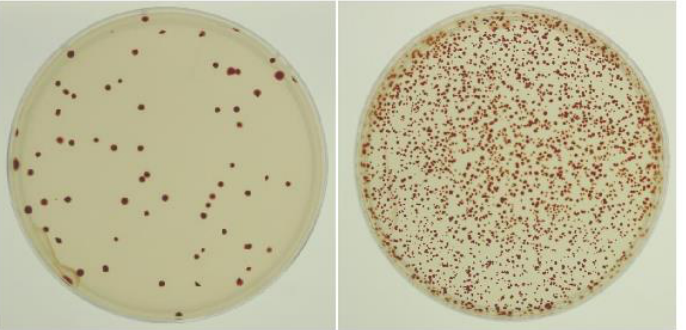
Figure 1. Representative plates from a transduction assay. ( Left ) mixed culture of strains DW5 and ∆ RC6 grown in the absence of antibiotic. ( Right ) mixed culture of strains DW5 and ∆ RC6 grown in the presence of Nb at 2 µg/mL, showing an estimated 30-fold increase in the number of colonies, and therefore gene transfer. Selection was for phototrophic growth, and each strain grown and plated alone yielded no colonies whatsoever.